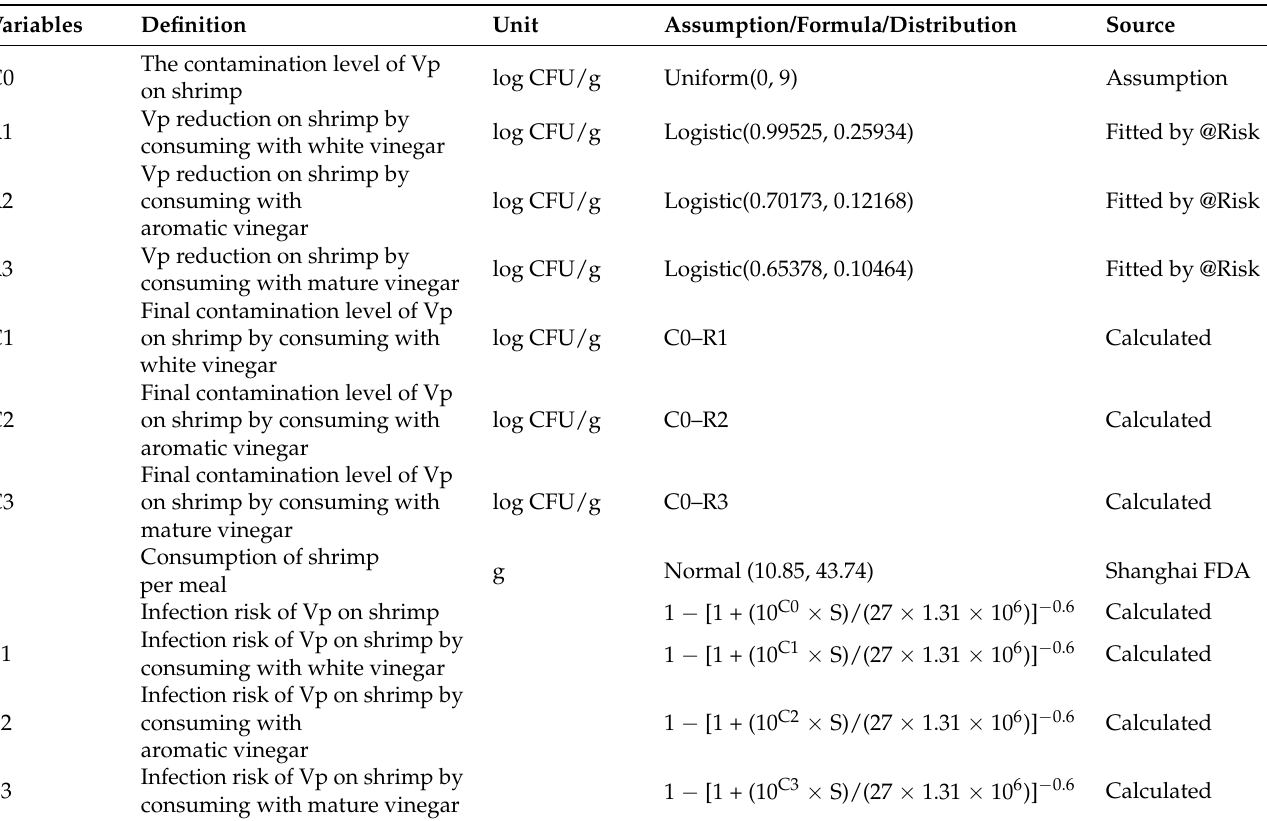
Table 2. Description and distribution of variables and models for risk reduction assessment of V. parahaemolyticus on ready-to-eat